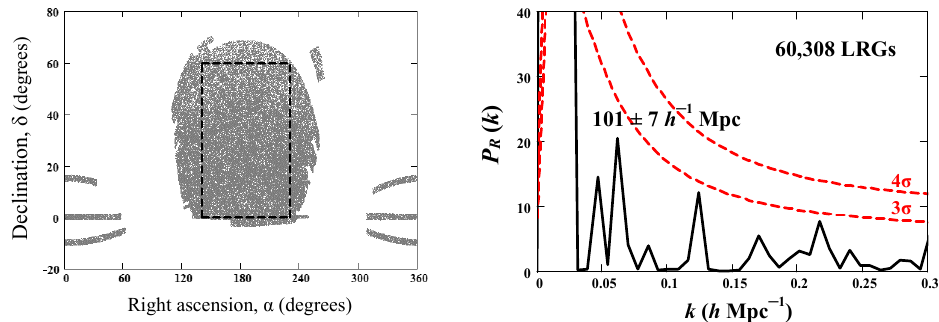
Figure 1. ( Left panel ): Angular distribution of LRGs over the sky from the SDSS DR7 data in the equatorial coordinate system; all grey colored regions comprise the DR7-Full sample in [35]; dashed lines delimit the rectangular region of our statistical consideration with α = 140–230 ◦ and δ = 0–60 ◦ , α and δ are defined about the axes, α is shown in a nonstandard way: east to right, west to left. ( Right panel ): Radial power spectrum P R ( k ) solid line calculated according to Equation (3) for all LRGs located in the rectangular region within the redshift interval 0.16 ≤ z ≤ 0.47 or distance interval 464 ≤ D ( z ) ≤ 1274 h − 1 Mpc. The significance levels 3 σ and 4 σ (dashed lines) are calculated using the mock LasDamas catalog and the exponential probability function (11) for random spectral peak amplitudes (see text).